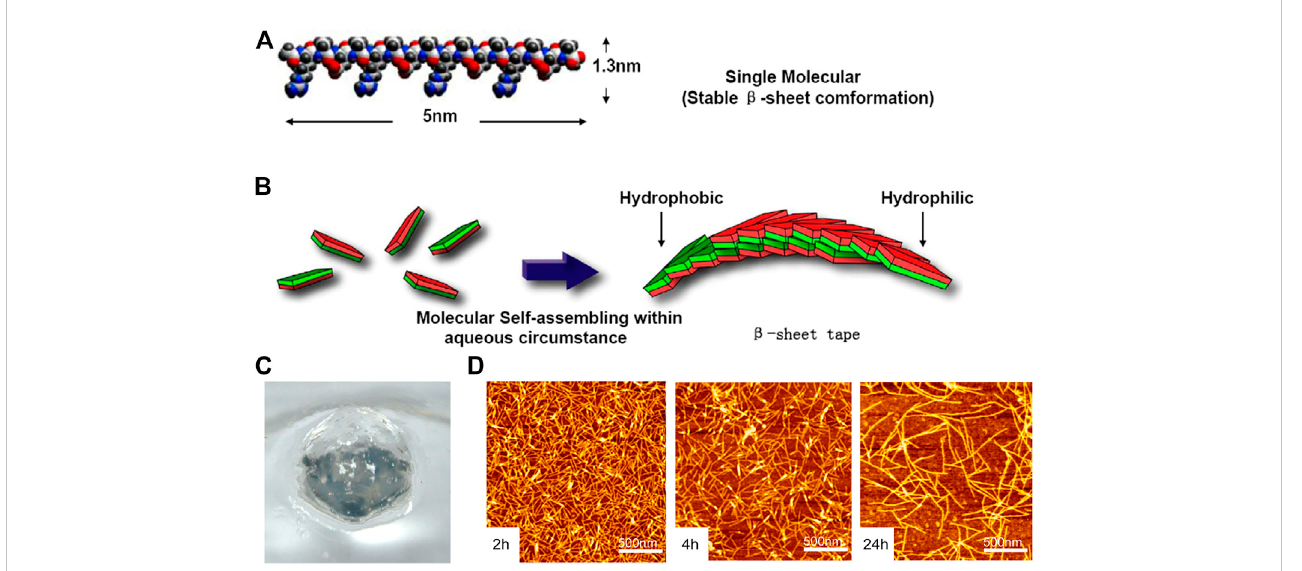
FIGURE 3 TheRADA16 isappliedinhemostasis. (A) Molecular modeloftheRADA16-1; (B) Molecularmodelofnumerous RADA16-1as theyundergo self-assembly to form nano fi bers with the hydrophobic alanine sandwiched inside and hydrophilic residues on the outside; (C) RADA16-1 gelatinized into hydrogel. Reproduced from (Wang et al., 2012) with permission from Copyright 2012. (D) AFM images of RADA16-I nano fi bers at various points in time after sonication. Note the elongation and reassembly of the peptide nano fi bers over